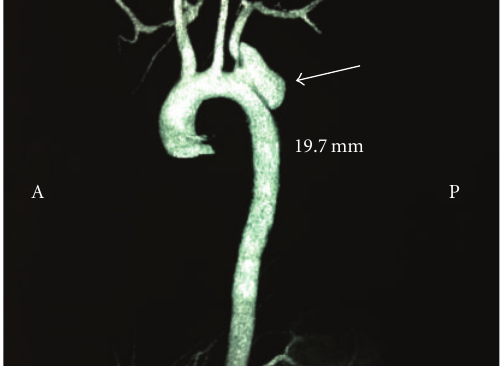
Figure 2: Angio-CT where we can appreciate the pseudoaneurysm (white arrow) which includes the origin of the left subclavian artery without a ff ecting the left carotid